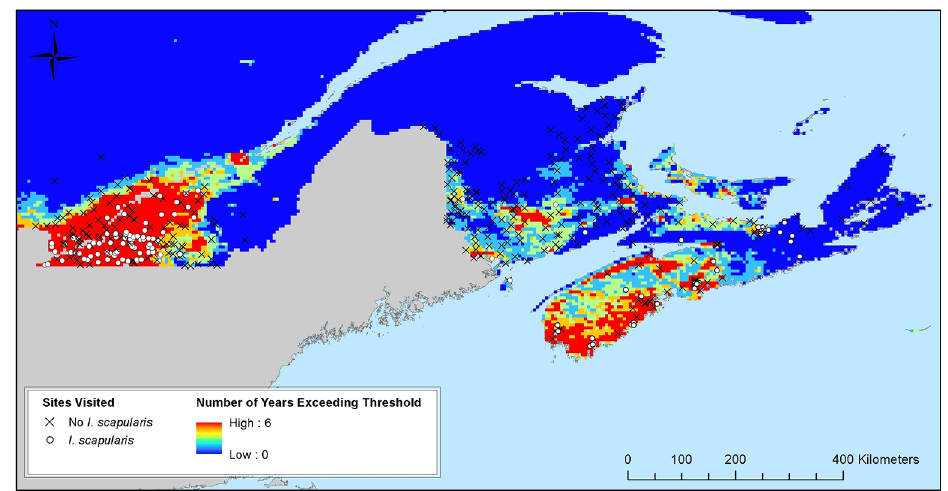
Fig 3. Relation of temperature conditions and results of field surveillance for I . scapularis in eastern Canada. The map shows the number of years from 2009 – 2014 in which DD > 0°C was greater than the model-based threshold for I . scapularis population survival obtained for southeastern Quebec and the Maritime provinces (New Brunswick, Prince Edward Island and Nova Scotia) from MODIS satellite data at a spatial resolution of 250 m. Sites where field surveillance for I. scapularis has occurred are indicated by circles (for locations where I . scapularis were found) and crosses (for locations where I . scapularis were not found). The map was created in ArcMap 10.2.2 (ESRI. Redlands, CA).